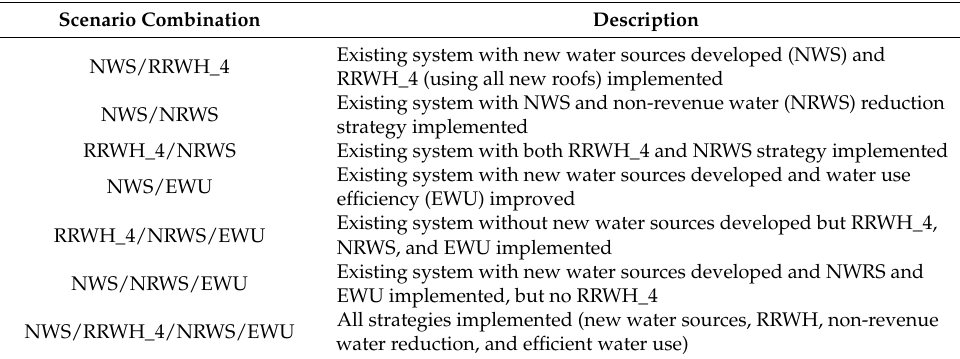
Table 7. Scenario combinations under the normal population growth